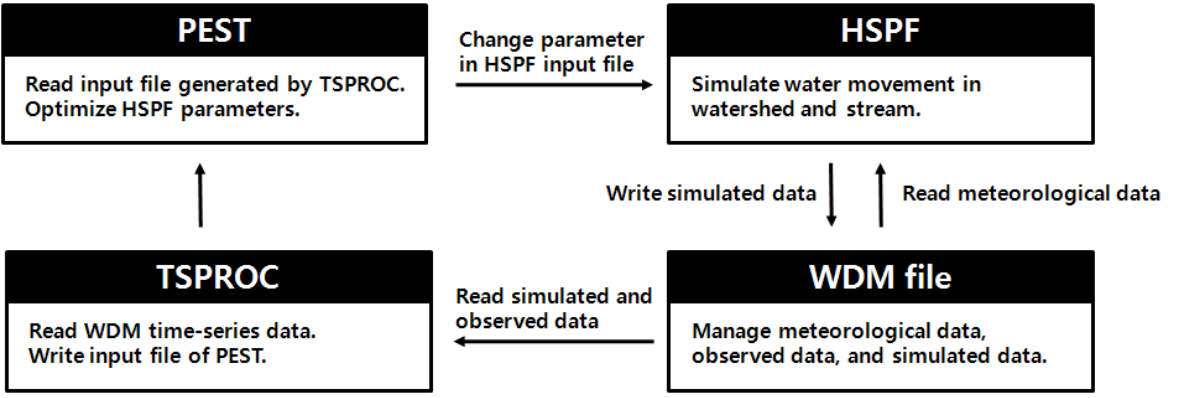
Figure 2. Overview interaction of The time series processor (TSPROC), Parameter Estimation and Uncertainty Analysis (PEST), HSPF, and Watershed Data Management (WDM)